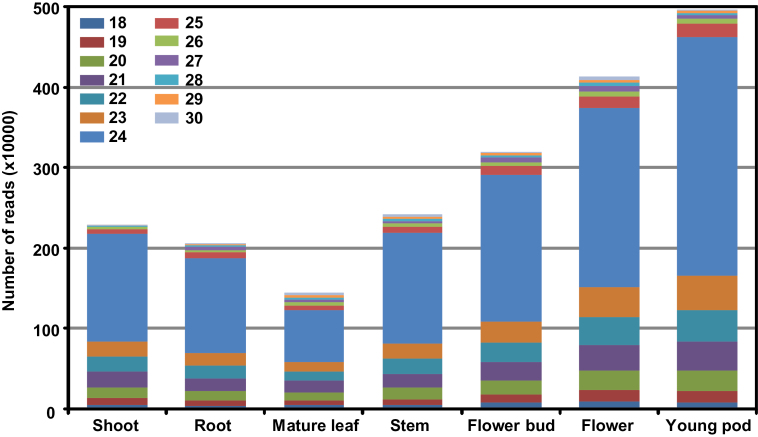
Size distribution of small RNA reads from seven chickpea tissues/organs. Number of high-quality filtered unique reads (after quality control and removal of redundant reads) of size 18–30 nt in different tissue samples is shown. This figure is available in colour at JXB online.